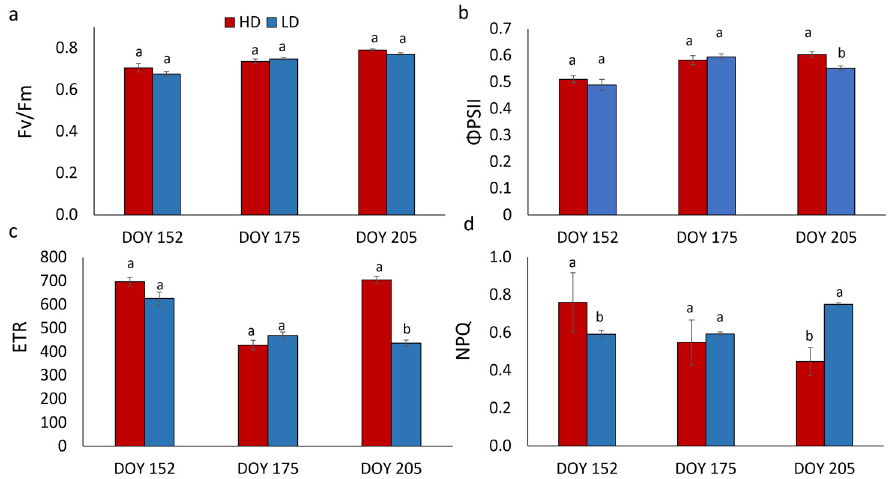
Figure 3. Maximum PSII photochemical efficiency (F v /F m ) ( a ), quantum yield of PSII electron transport ( Φ PSII ) ( b ), linear electron transport rate (ETR) ( c ), and non-photochemical quenching (NPQ) ( d ) in R. pseudoacacia HD and LD plants at DOY 152, 175, and 205. Mean values and standard errors are shown. Different letters correspond to statistically significant differences ( p < 0.05) within each date of sampling.